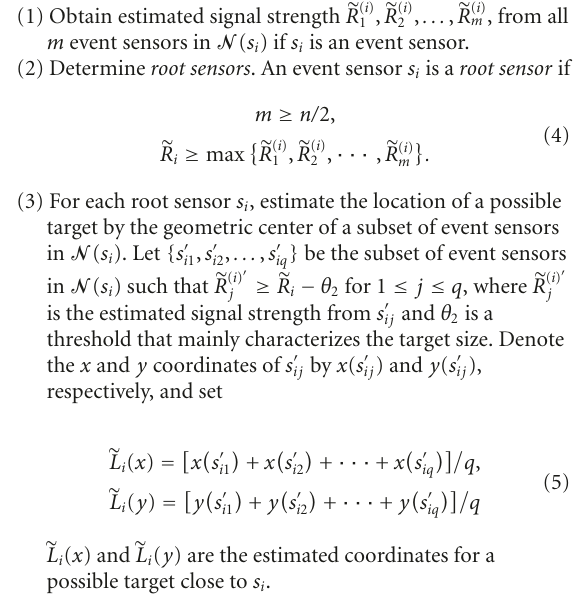
Algorithm 2: For target